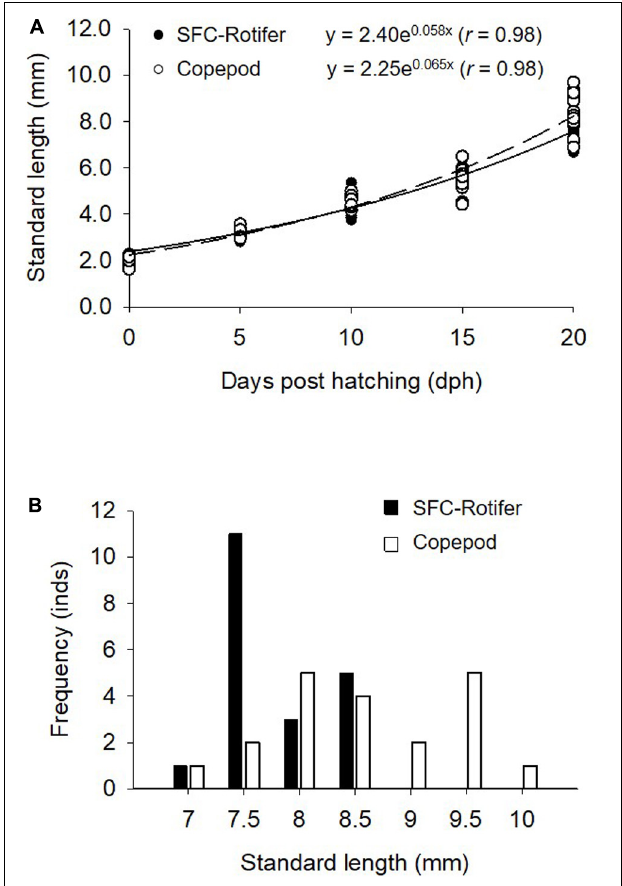
FIGURE 4 | Growth curve for Pagrus major larvae reared under different feeding regimes (A) and a histogram of larval standard length at the end of rearing periods (20 days post hatching) (B) . The curve for larvae fed rotifers (SFC-Rotifer; solid line) and those fed copepods (broken line) is fitted based on data from 20 samples obtained at 0, 5, 10, 15, and 20 dph.